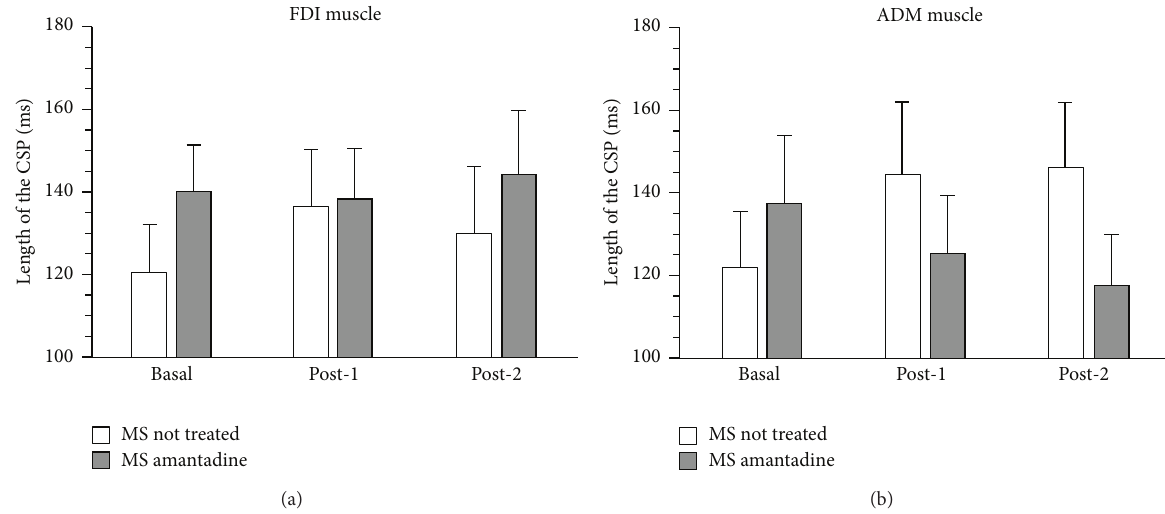
Figure 3: Histograms represent the mean ( ± SE) duration of the cortical silent period (CSP) from the FDI (a) and ADM (b) muscles at basal conditions and following two progressively fatiguing tasks (Post-1 and Post-2) recorded in MS patients before and after the amantadine treatment. Statistics of the repeated measures ANOVA are reported in the